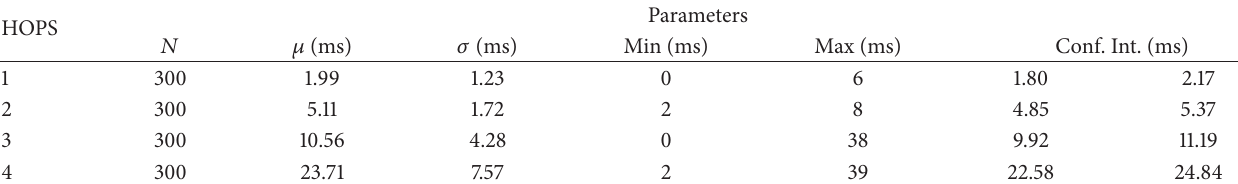
Table 5: Statistical values of the jitter as a function of the